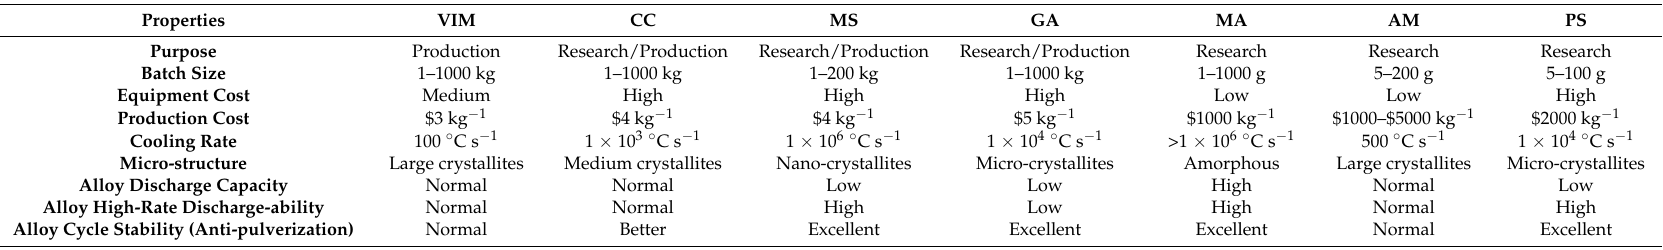
Table 2. Comparison between alloy preparation methods. VIM, CC, MS, GA, MA, AM, and PS are short for vacuum induction melting, centrifugal casting, melt spinning, gas atomization, mechanical alloying, arc melting, and plasma spray,